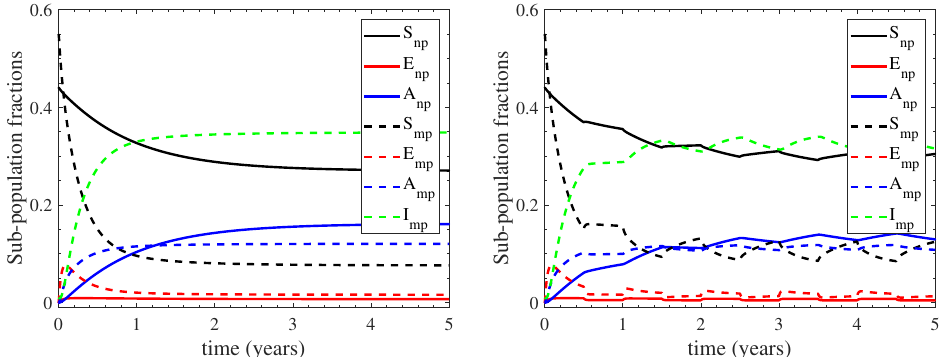
Figure 4. Evolution of the sub-populations profiles for the continuous ( left ) and seasonal ( right ) hous- ing cases considered; in the latter case the herd remains indoors/outdoors during the first/second half of each year. The nulliparous sub-populations are depicted with sold curves, while the multiparous ones with dashed